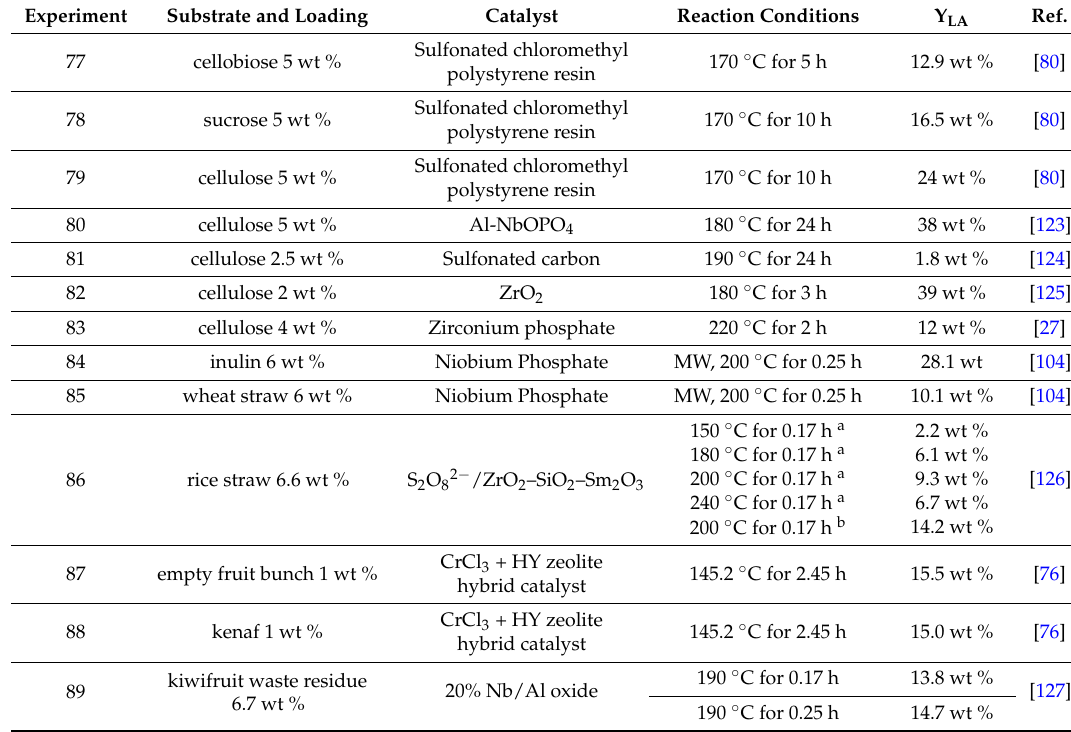
Table 5. Polysaccharides and raw and waste biomasses conversion in water in the presence of heterogeneous catalysts: reaction